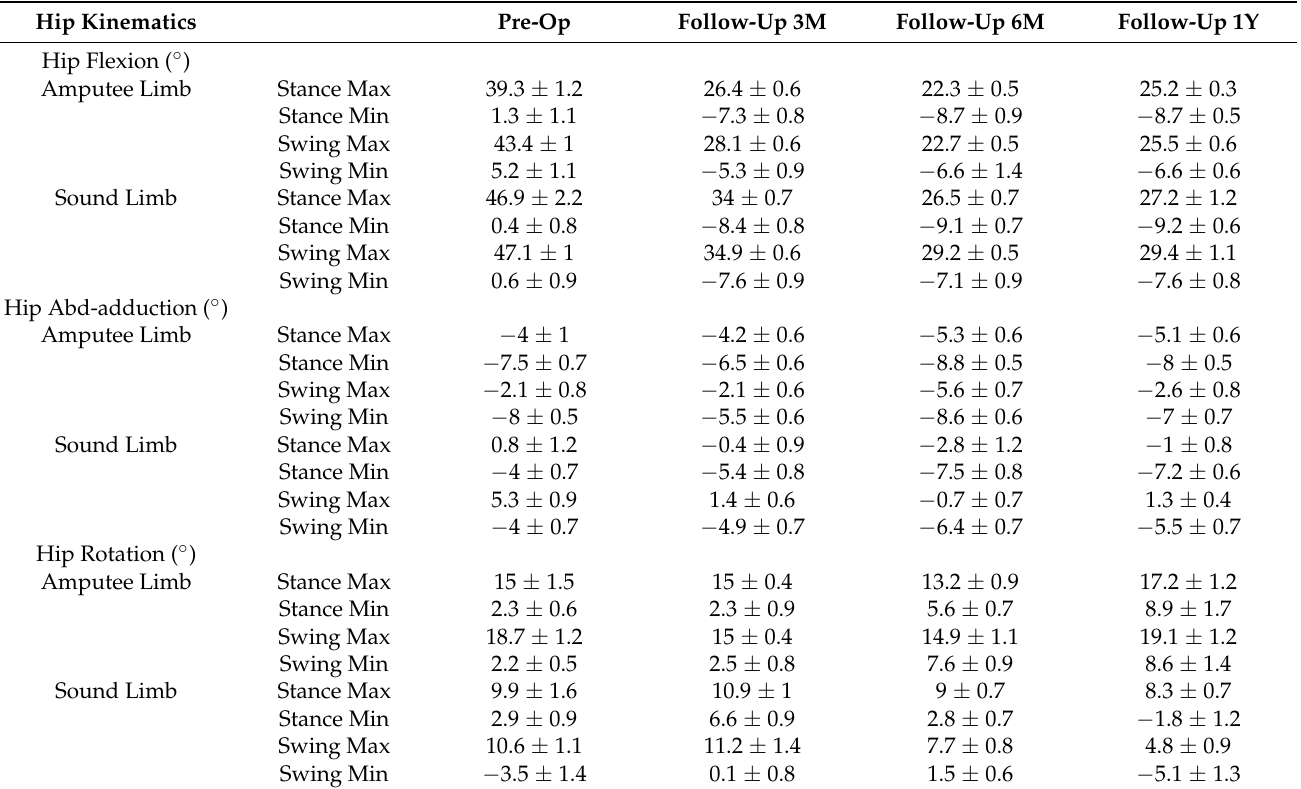
Table A3. Descriptive peak hip joint kinematics for the amputee and sound limb in the pre-operative gait analysis (socket-type prosthesis, ST) and the follow-up gait analyses (osseointegrated prosthesis, OI). Data are presented for the self-selected gait as mean ± standard deviation separately for stance and swing phases.